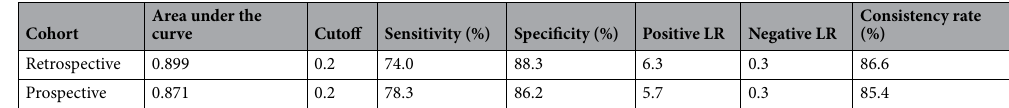
Table 6. Predictive value of the predictive scale. Receiver operating characteristic curve analysis was performed with suitable parameters to create cutoffs to determine the predicted probability with regard to refractory M. pneumoniae pneumonia. LR, likelihood